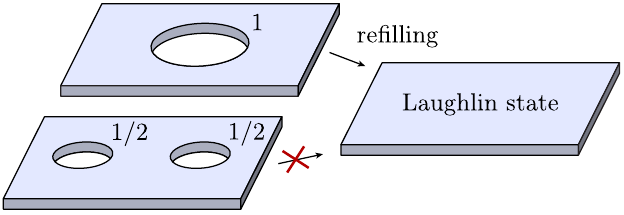
Figure 1: Conceptual picture for the stabilization of the photonic Laughlin state at half-filling. Full hole in the Laughlin state is refilled by adding a photon locally. At the same time two remote quasiholes – which also correspond to the absence of a single photon – cannot be refilled by the stabilization setup. This is because a real (i.e. “bare”) photon cannot break into two pieces, in contrast to a hole in the fractional quantum Hall state that can break into two